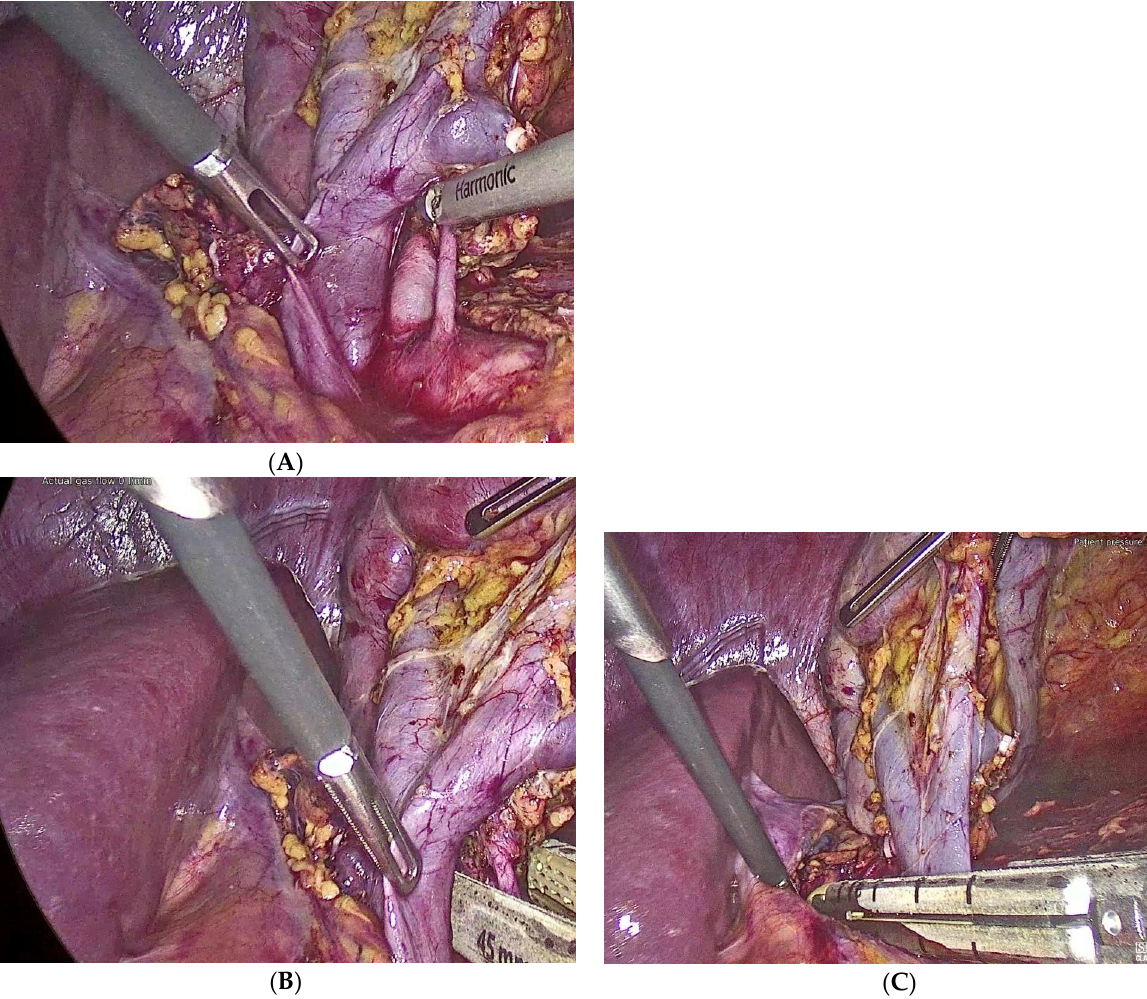
Figure 2. Port placement for laparoscopic donor nephrectomy (LDN). ( A ) Dissection of the renal arteries. ( B ) Control of the renal arteries with the vascular Endo-GIA. ( C ) Control of the renal vein with the vascular Endo-GIA. (2) ODN (Flank